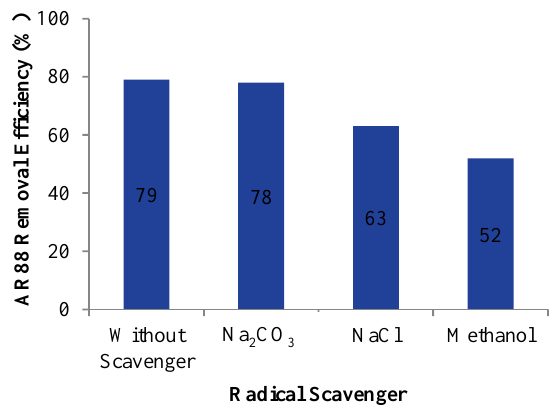
Figure 6. Effect of radical scavengers on the photocatalytic removal of Acid Red 88 (AR88) from aqueous solutions (initial dye concentration: 50 mg/l, pH: 7, time: 120 minutes)